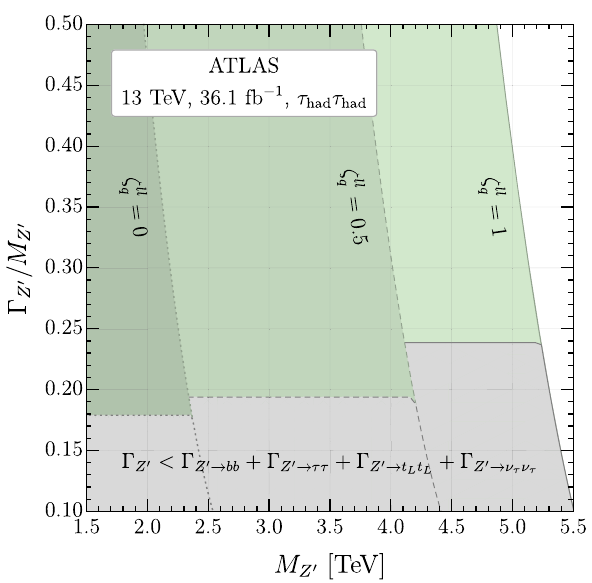
Fig. 4 95% CL exclusion limits from the pp → ττ search in the ( M , M ) plane for different values of the gauge couplings g U Z (cid:2) All couplings to light quarks are set to